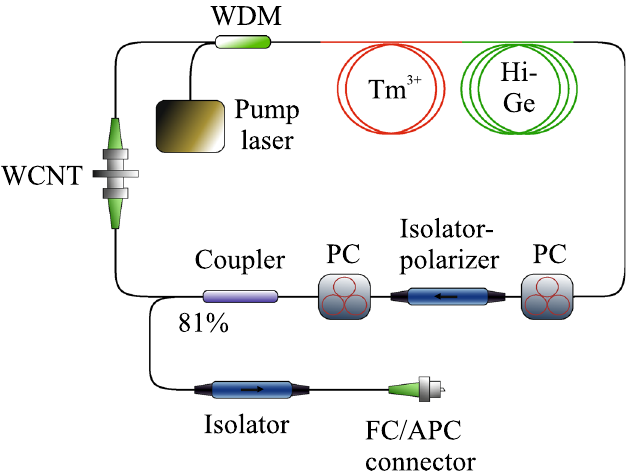
Figure 1. Scheme of the thulium-doped fibre ring laser with hybrid mode-locking, WDM: wavelength-division 3 + multiplexer, PC: polarisation controller, Tm : thulium-doped fibre, Hi–Ge: fibre with high concentration of germainum oxide, SWCNT: single wall carbon